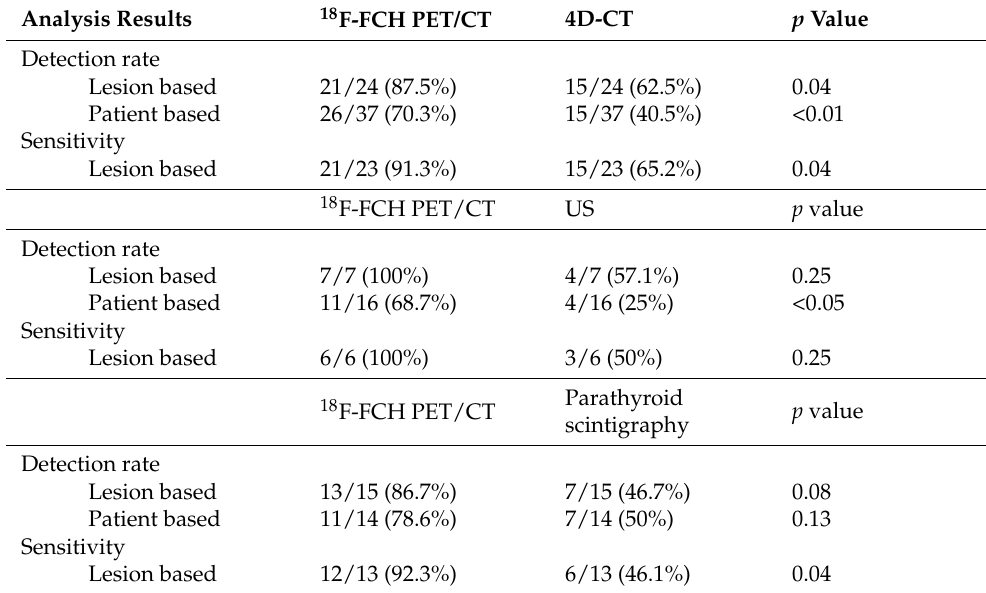
Table 3. Comparisons between 18 F-FCH PET/CT and 4D-CT, US, and parathyroid scintigraphy. Analysis